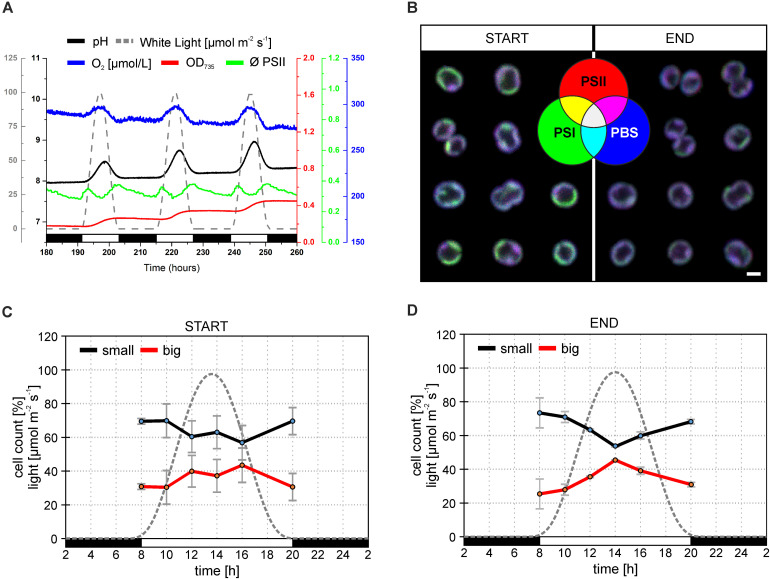
Behavior of Synechocystis PSI-YFP cells during cultivation in the bioreactor. The original starting culture (“START”; cells acclimated to continuous light; days 2 and 3 in the bioreactor) was slowly acclimated to the sinusoidal light-dark cycle (12/12 h marked by white/black bars, maximal intensity 100 μmol m– 2 s– 1). The light intensity profile is depicted as a gray dotted line. Cells grew in the bioreactor for 2 weeks to be considered as acclimated to the light-dark cycle (“END”; days 13 and 14 in the bioreactor). (A) Dynamic behavior of Synechocystis PSI-YFP cells during cultivation in the bioreactor in situ. Parameters represent: (1) OD735 optical density (red line) measured at 735 nm representing growth of biomass; (2) pH of culture (black line); (3) O2 dissolved in water (blue line); (4) ϕPSII (green line) representing actual PSII efficiency under red light; (5) light intensity (μmol m– 2 s– 1; gray dashed line). Data represent typical behavior of the parameters for days 6, 7, and 8 of bioreactor experiment. (B) Confocal microscope images of Synechocystis PSI-YFP cells at the start (days 2 and 3) and at the end (days 13 and 14) of bioreactor experiment. Three channel RGB pictures represent three acquired fluorescence signals showing localization of three complexes: (1) red—PSII autofluorescence; (2) blue—PBS autofluorescence; (3) green—PSI-YFP fluorescence. A combination of these three signals provides four additional membrane areas reflecting the co-localization of PSI/PSII/PBS. Overlapping signals create: (4) magenta—dominant PSI and PSII (low PBS); (5) cyan—dominant PSI and PBS (low PSII); (6) yellow—dominant PSI and PSII (low PBS); (7) white—PSI, PSII, and PBS are in similar, high content. Pictures represent typical thylakoid membrane organization of Synechocystis PSI-YFP during bioreactor experiment. Total number of analyzed cells per day was between n = 709 and 1565. (C,D) Confocal microscope measurements of cell sizes during the diel cycle, based on acquired images, two cell categories were counted: small (black line, cell area 2.0–2.8 μm2); big (red line, cell area 2.8–4.0 μm2). Data represent averages and SD at the start (C; days 2 and 3) and at the end (D; days 13 and 14) of the bioreactor experiment. Data represent averages of two different days of the bioreactor experiment.